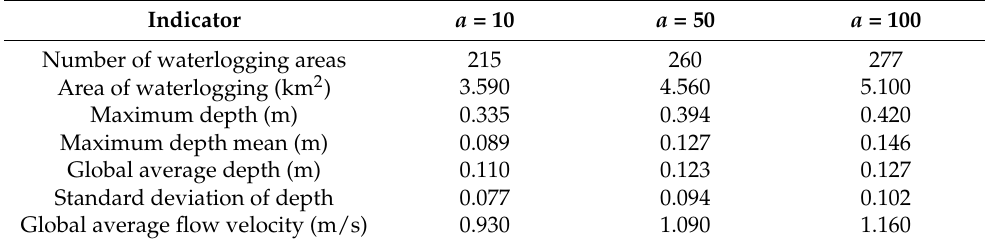
Table 7. Statistical results of water accumulation depth under three rainfall